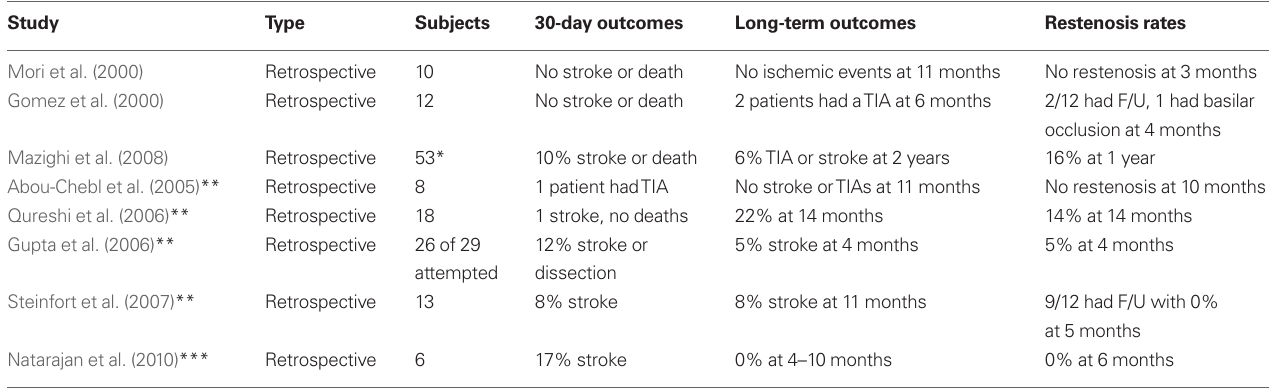
*Only 76% of patients were treated with stents. **Studies using drug-eluting stents. ***Second generation drug-eluting stent.